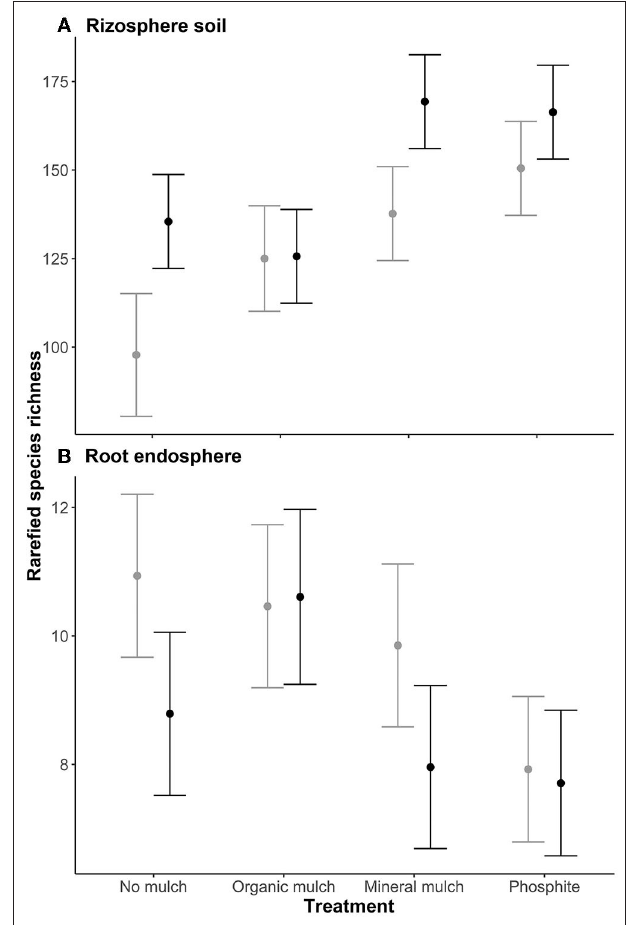
FIGURE 1 | Alpha diversity of the microbial biome of (A) rhizosphere soil and (B) root endosphere of avocado plants given four soil treatments. Yellow boxplots show alpha diversity, measured by the Shannon diversity index for non-infested avocado, blue boxes represent plants infested with Phytophthora cinnamomi. Different lowercase letters indicate a significant ( P < 0.05) difference.